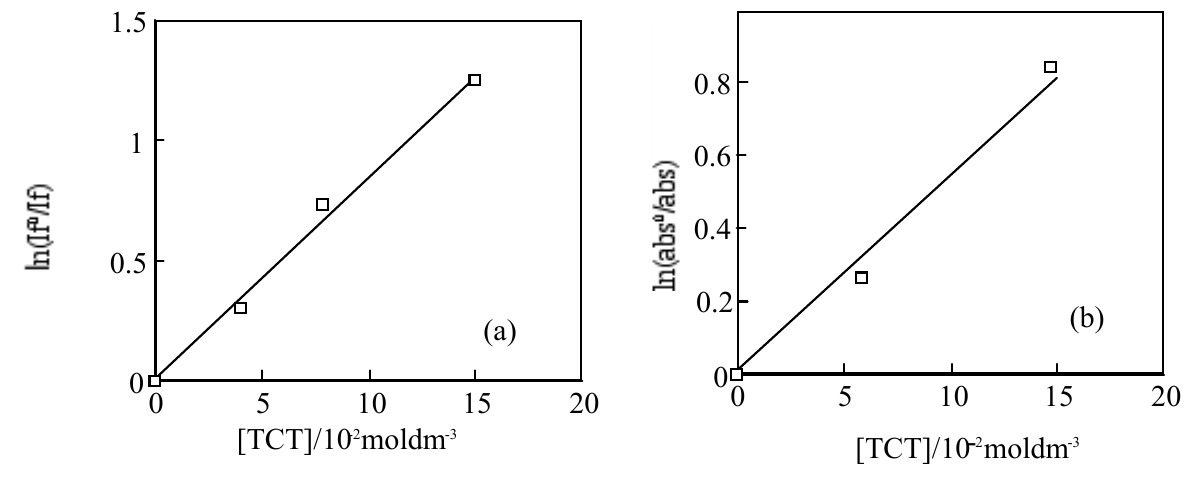
Figure 19. Quenching of 6 by TCT in PMMA. (a) Fluorescence on 572 nm. Substance concentration: 0.03 mol·L -1 ; Excitation wavelength: 550 nm; (b) Triplet absorption intensity on 450 nm. Substance concentration: 0.15 mol dm − 3 ; Excitation wavelength: 355